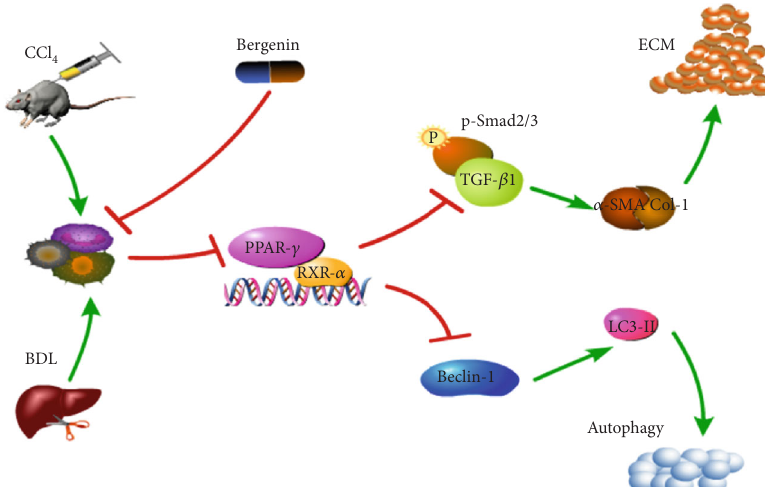
Figure 5: Mechanism of action of bergenin in liver fi brosis. The expression of PPAR- γ and RXR- α was increased, and the TGF- β pathway was inhibited following treatment with bergenin. The Smad2/3 that act downstream were not activated by phosphorylation and transported into the nucleus. Furthermore, Beclin-1 could not be bound to promote transcription, which reduced the likelihood of LC3-I to LC3-II transformation, which decreased fi brosis due to a lack of energy supply for HSC